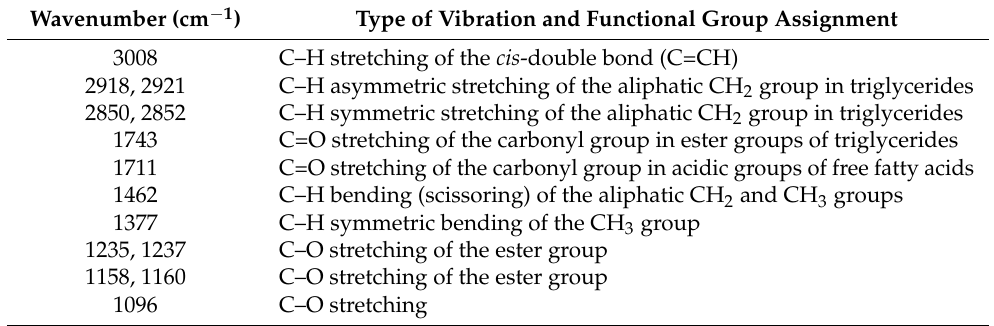
Table 5. Peak assignment for CRBO from different extraction